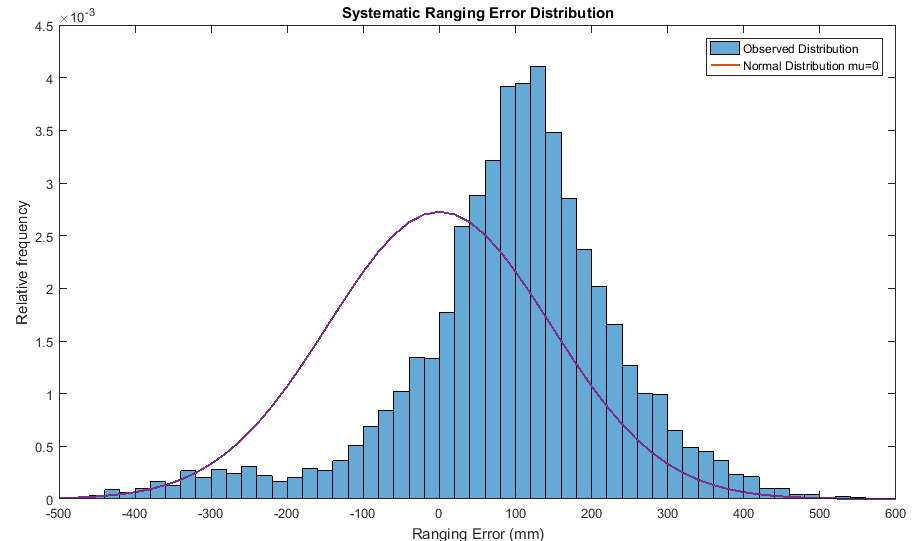
Figure 14. Systematic ranging error